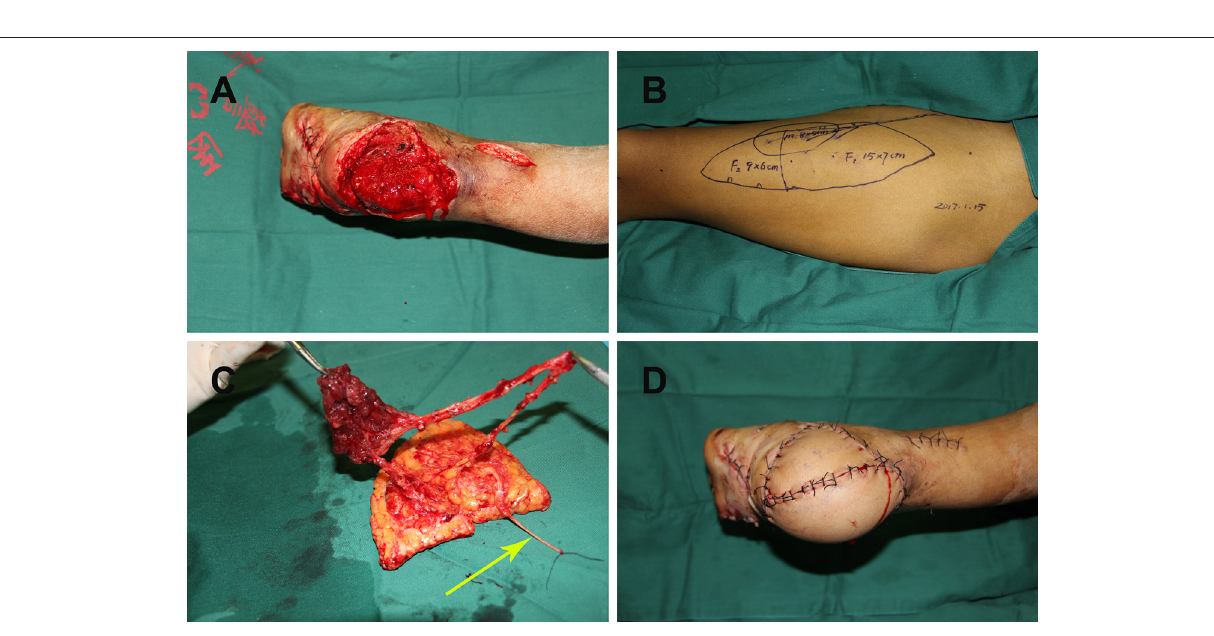
FIGURE 3 | (A) Right heel soft tissue defect with dead space following radical debridement; (B) chimeric double skin paddle ALT flap design; (C) harvesting of chimeric double skin paddle ALT flaps showing the lateral femoral cutaneous nerve (yellow arrow); (D) postoperative view of the recipient site. ALT, anterolateral thigh